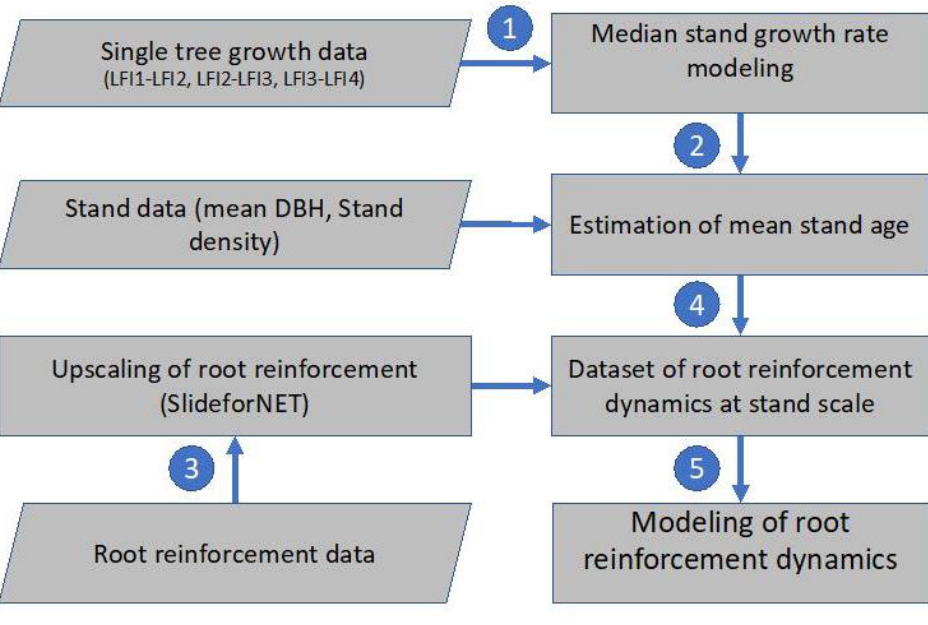
Figure 1. Flowchart showing the datasets and modeling steps done to quantify and model the temporal dynamics of root reinforcement in spruce